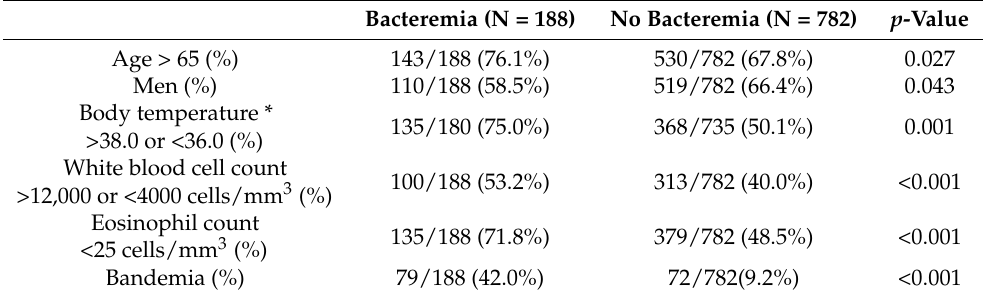
Table 1. Characteristics of the distinguished groups (bacteremia and no